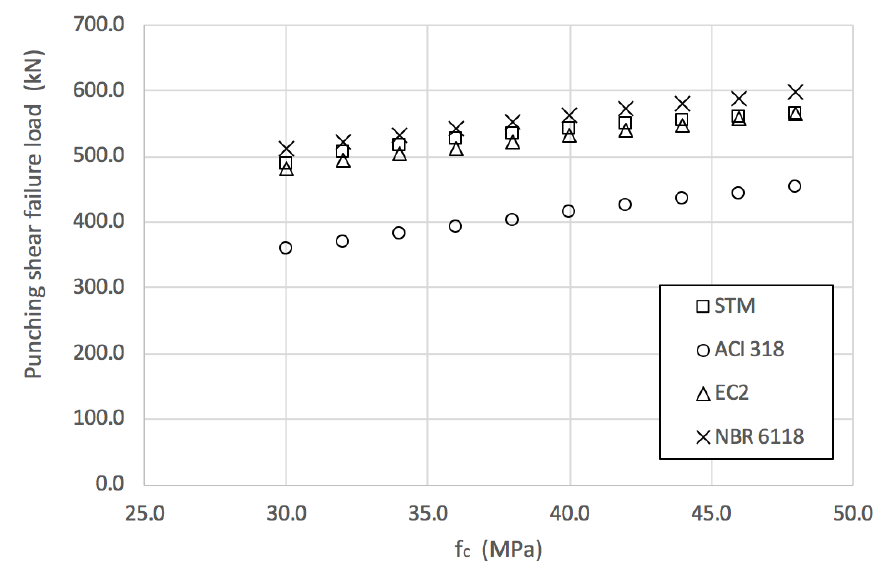
Figure 8. Resistance to concrete compression versus punching shear resistance - Group B slabs.